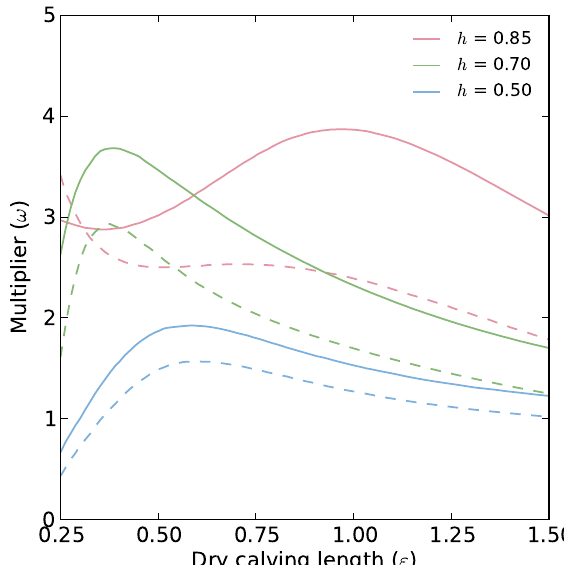
Fig. 9. The effect of a change in surface slope on the ω − ε relation- ship. Dashed lines show the relationship with a surface slope of 5 ◦ . Note that in this case, h refers to the waterline height at the ice front only, with effectively smaller values of h further from the